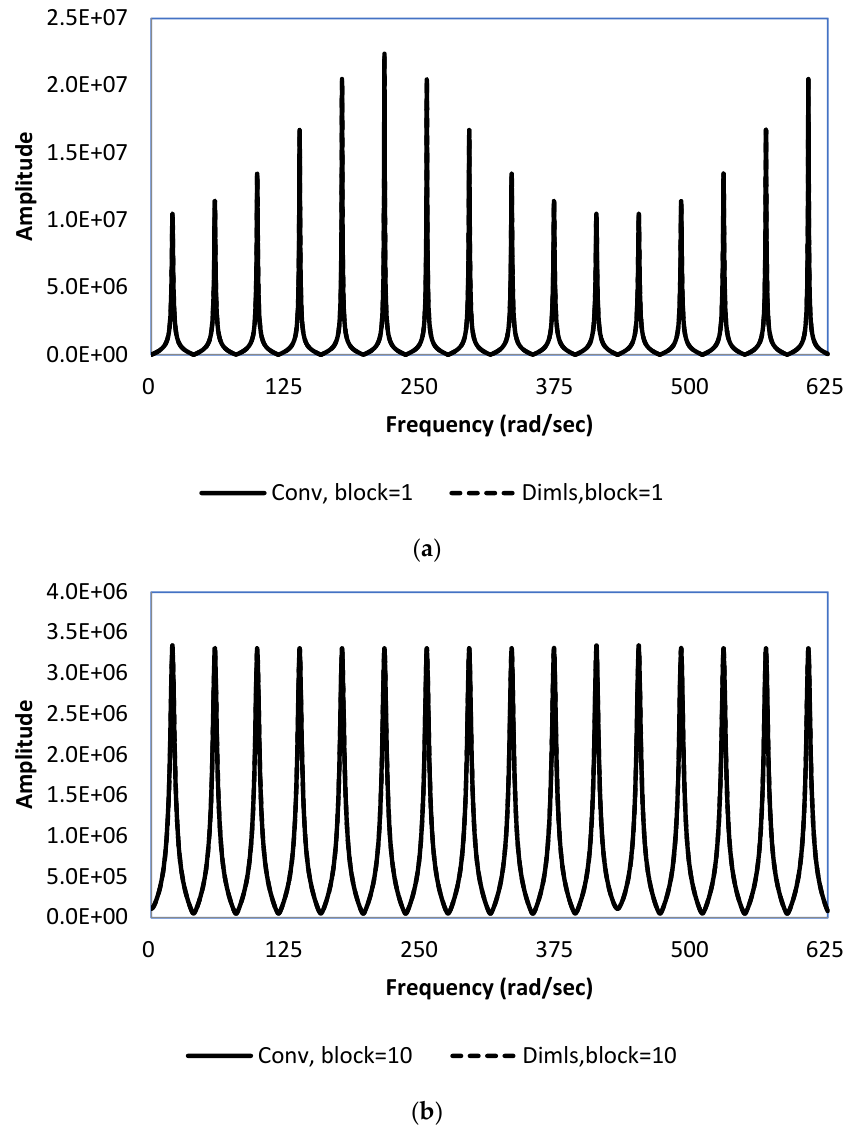
Figure 3. Distributions of impedance amplitudes of conventional formulation and MDBF of the acceleration ‐ based friction model for partial blockage with one ( a ), and ten ( b )